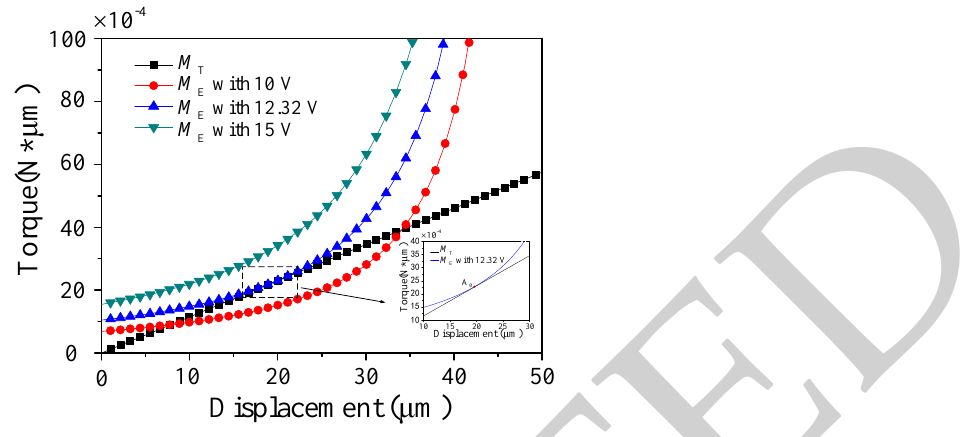
Figure 6. Relation between displacement of upper electrode tip and torque under different driving voltage.